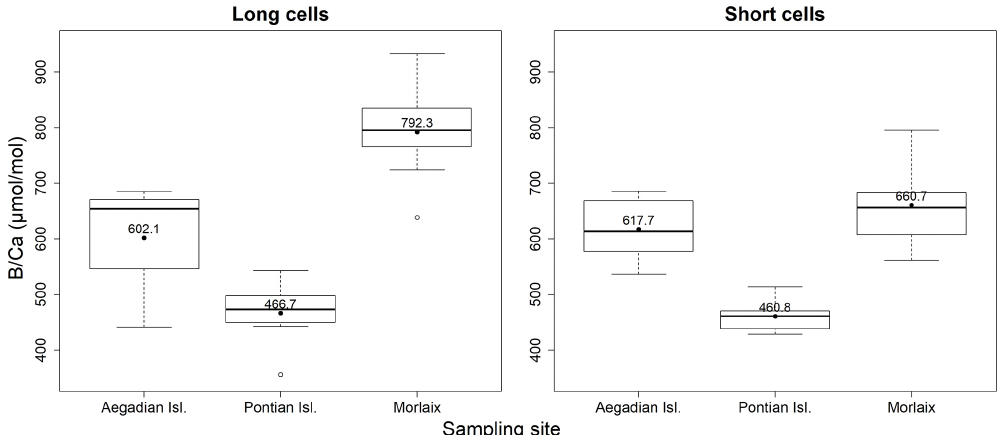
Figure 10. Box plots of the statistical tests performed to evaluate the differences of B / Ca in the long and short cells of L. corallioides collected at different sampling sites. The horizontal black lines indicate the median values. The black dots and the numbers inside the plot indicate the mean values.